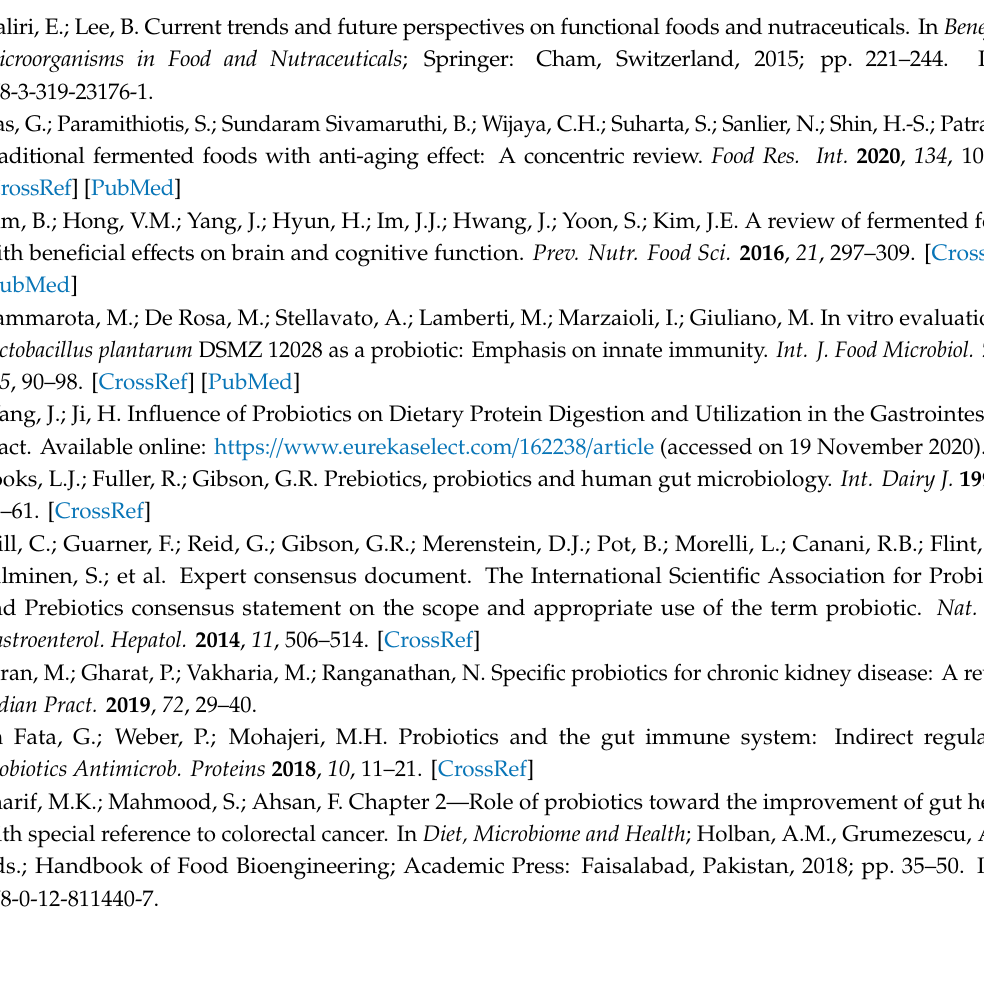
Figure S1: Acid tolerance and bile tolerance; Figure S2: Circular maps of the selected B. subtilis strains; Figure S3: ANI tree analysis of B. subtilis 5 strains SRCM103517, SRCM103571, SRCM103576, SRCM103689, and SRCM104011 (in this study) and other 24 strains previously isolated in Korea; Figure S4: Phylogenetic analysis of amino acid sequences of surfactin synthase subunits SrfAC and SrfAD in the total 29 B. subtilis strains including 5 strains (in this study) and other 24 strains previously isolated in Korea. Table S1: Antimicrobial activity against five pathogenic bacteria B. cereus KCTC3624, B. cereus KCCM40935, S. aureus KCCM11335, L. monocytogenes KCCM43155, and E. faecalis KCCM11814; Table S2: General genome features of the B. subtilis SRCM103517, SRCM103571, SRCM103576, SRCM103689, and